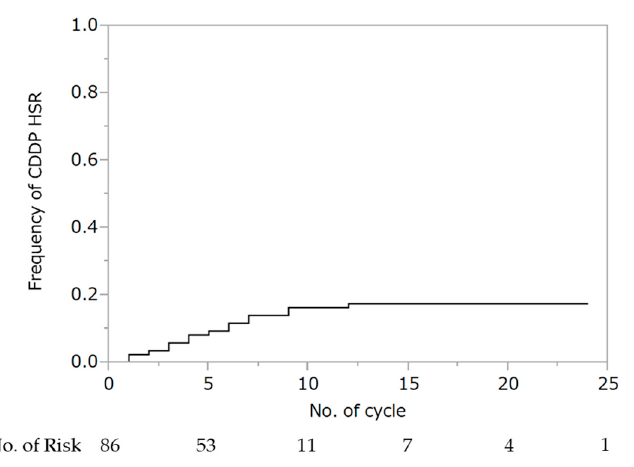
Figure 1. Cumulative rate of hypersensitivity reaction to cisplatin. Abbreviations: HSR, hypersensitivity reaction.